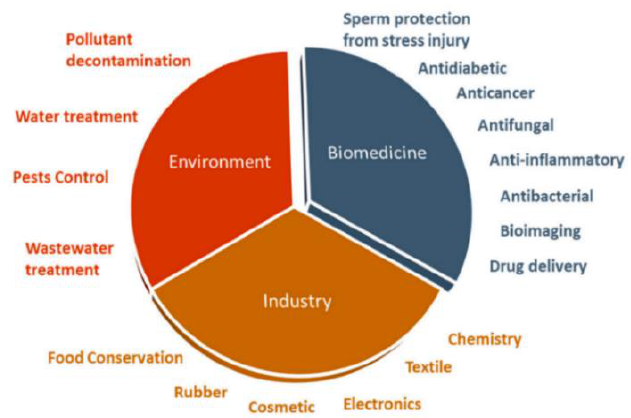
Figure 1. A wide variety of applications of ZnO nanoparticles in biomedicine, industry, and environment. Reproduced from [21] with permission of MDPI under the terms of the Creative Commons Attribution license.